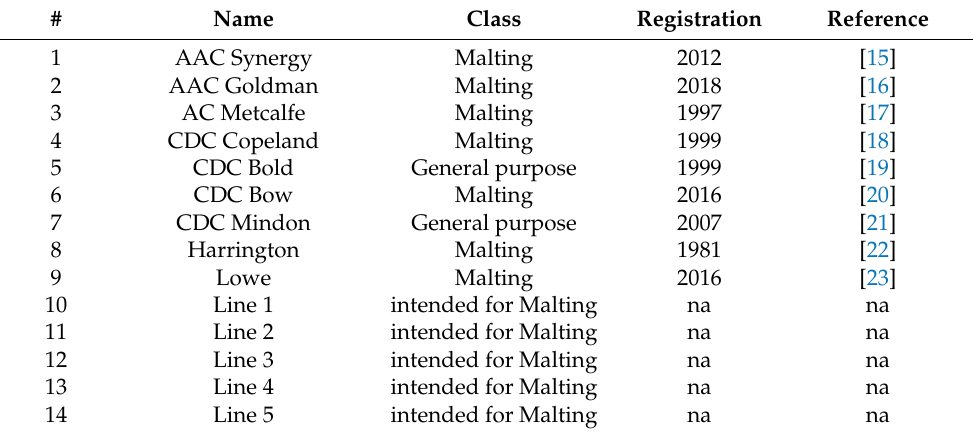
Table 1. List of the two-row spring hulled cultivars and elite breeding lines used in the study.